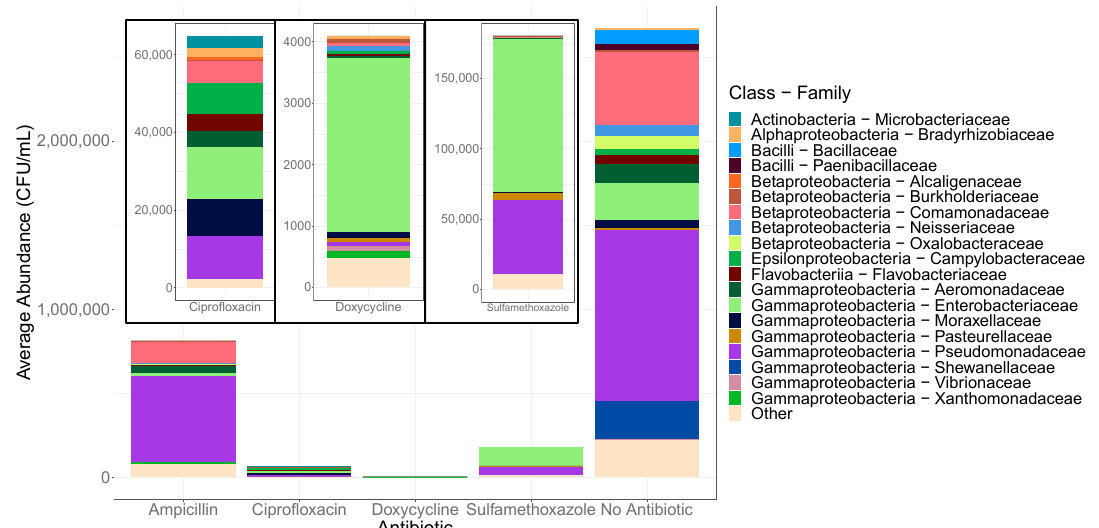
Figure 4. CFU/mL normalized counts from relative abundance data of the taxonomic families from each cultured antibiotic Figure 4. CFU/ml normalized counts from relative abundance data of the taxonomic families from treatment. The average colony counts for each location were normalized to CFUs per ml and adjusted to the calculated each cultured antibiotic treatment. The average colony counts for each location were normalized relative abundance determined through 16s rRNA sequences to obtain approximated absolute abundances. Families making to CFUs per ml and adjusted to the calculated relative abundance determined through 16s rRNA up <1% of the total community at each site were sequences to obtain approximated absolute abundances. Families making up < 1% of the total community at each site were excluded.